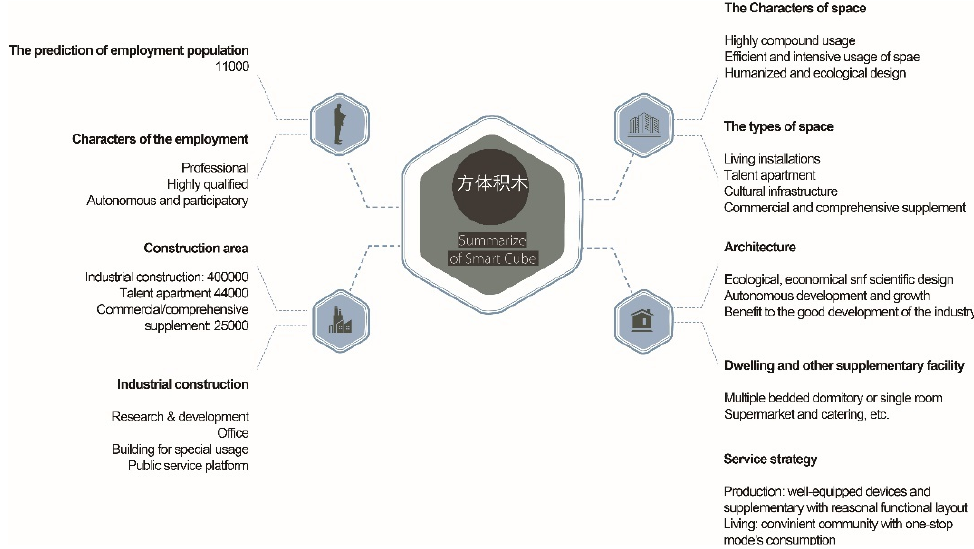
Figure 12. Schematic diagram for forecasting the employed population, architectural scale, and spatial characteristics within the proposed community. It is named the “Smart Cube” (Source: